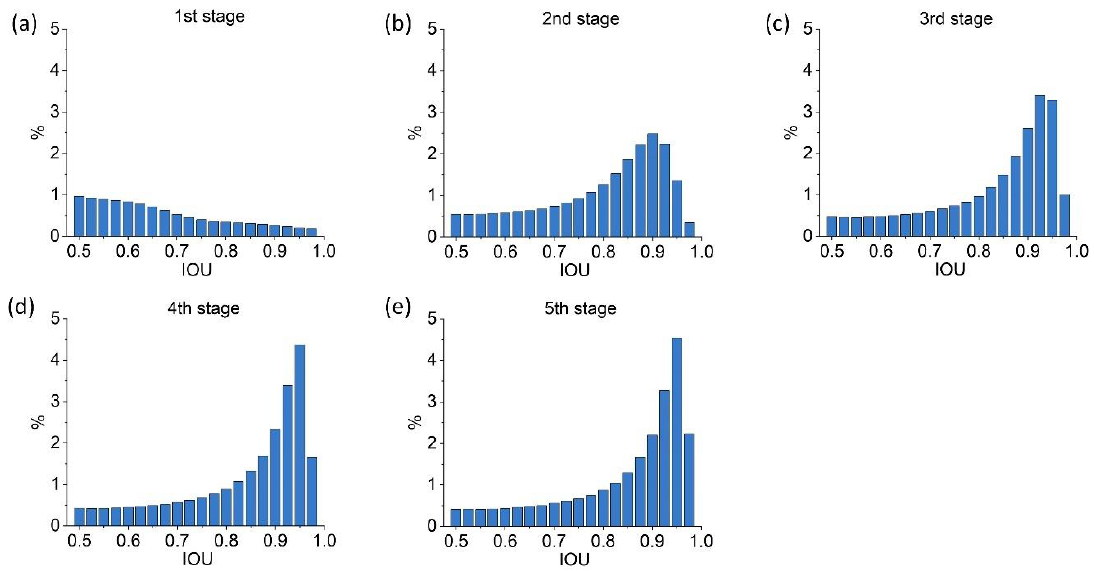
Figure 1. Intersection-over-union (IoU) histograms of training samples of the ( a ) first, ( b ) second, ( c ) third, ( d ) fourth, and ( e ) fifth stages in Cascade R-CNN. The histogram of the first stage represents the IoU distribution of region proposals produced by RPN.